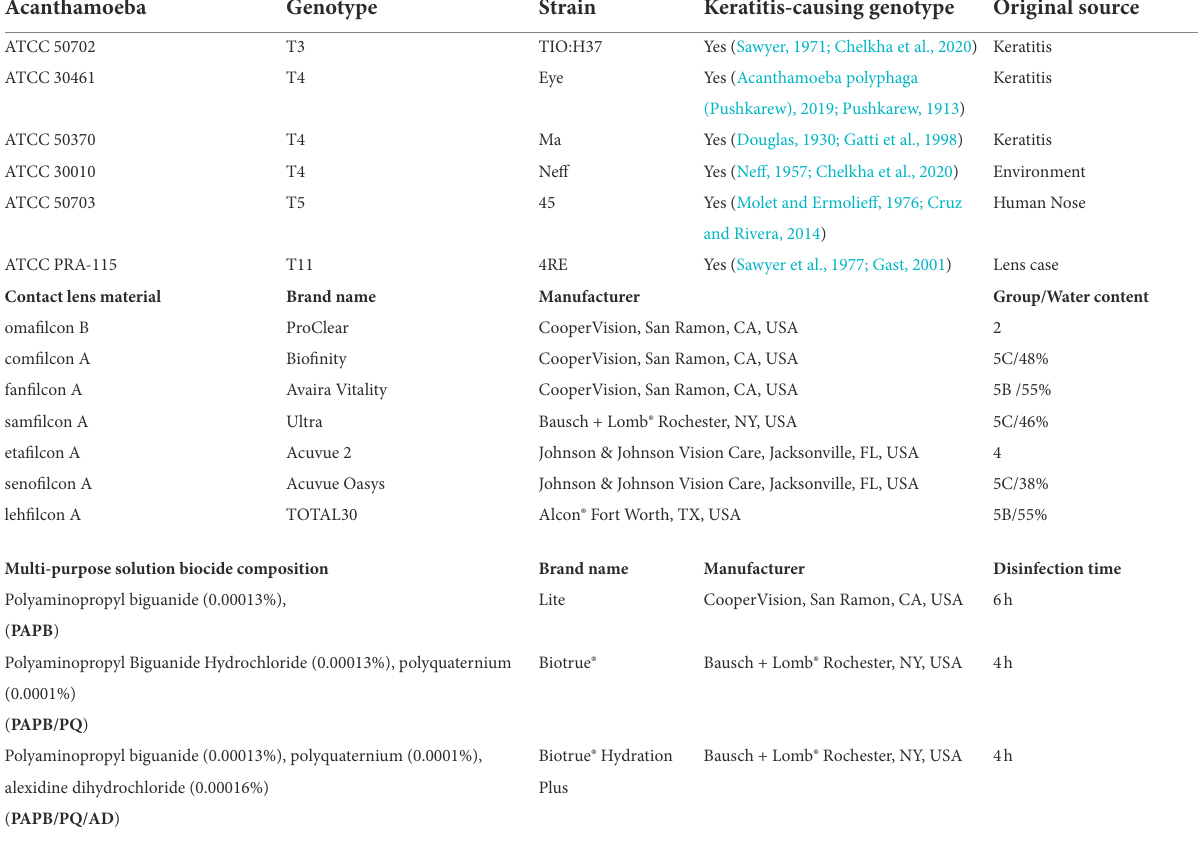
TABLE 1 Description of the strains of Acanthamoeba used (de Lacerda and Lira, 2021) contact lens material tested, and multi-purpose solutions used.